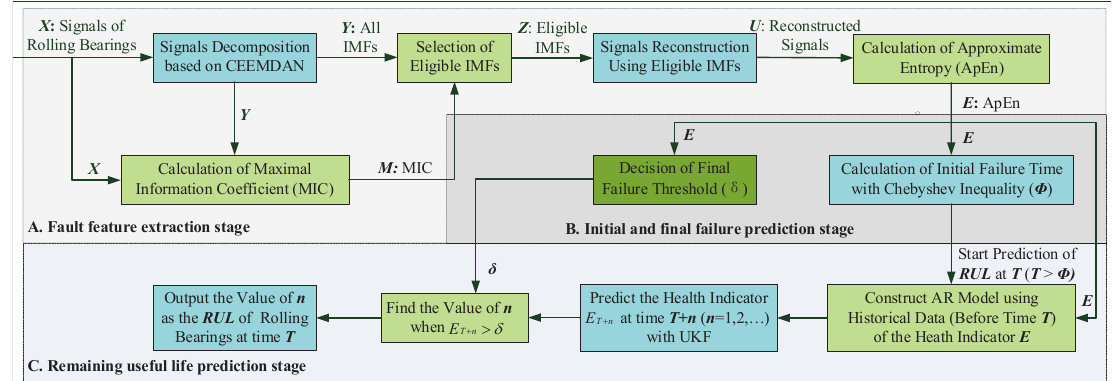
Figure 1. Functional block diagram of the proposed method. CEEMDAN = complete ensemble empirical mode decomposition with adaptive noise; IMFs = intrinsic mode functions; ApEn = approximate entropy; UKF = unscented Kalman filter; RUL = remaining useful